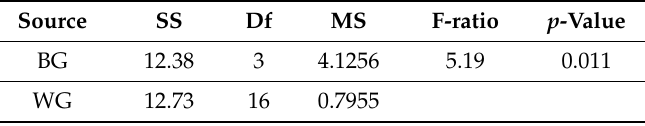
Table 7. ANOVA test for impact strength of five samples.